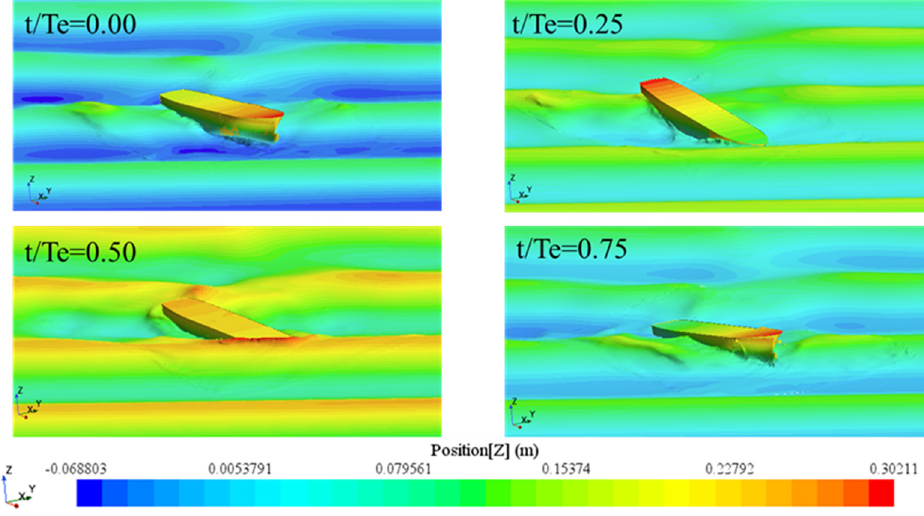
Figure 20. Waveforms in one cycle (Case CY9).